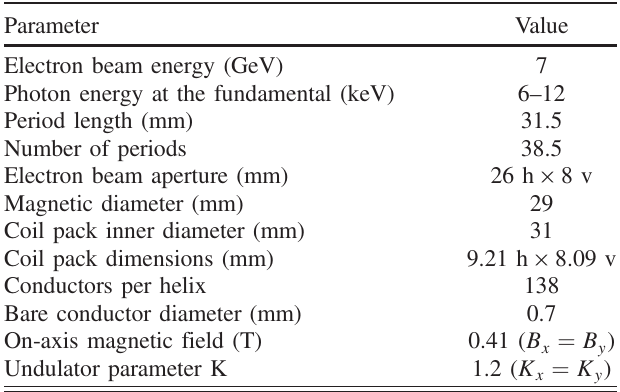
TABLE I. Design parameters of the HSCU.